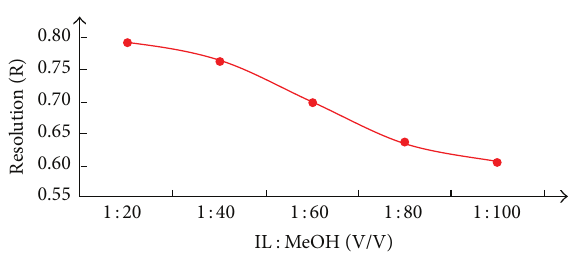
Figure 2: Effect of [BMIM]OH concentration on 𝑅 𝑓 values of berberine hydrochloride.